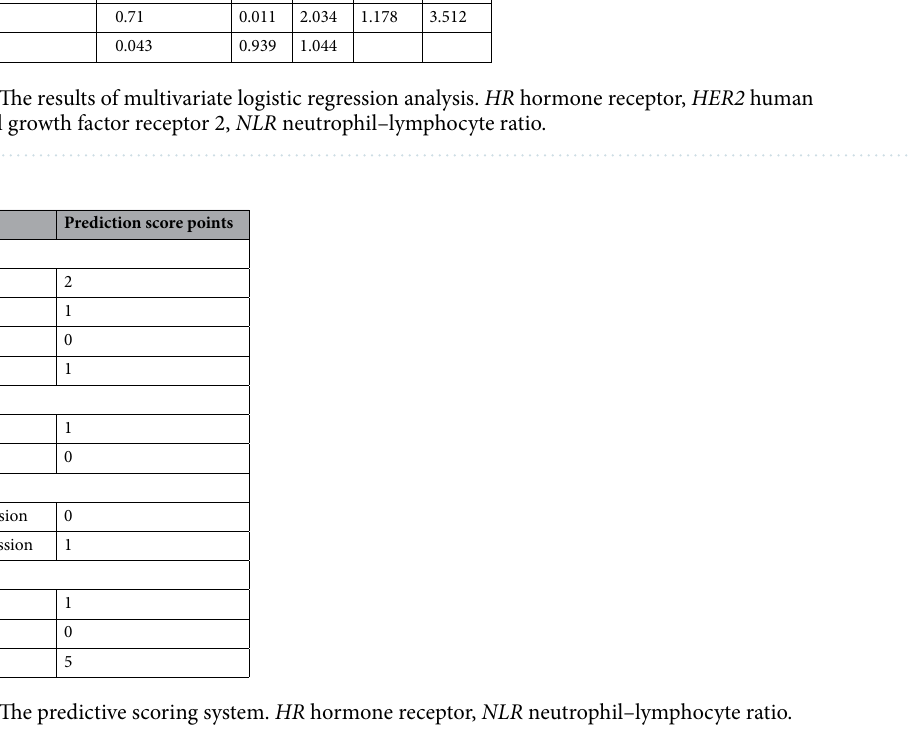
Table 4. The predictive scoring system. HR hormone receptor, NLR neutrophil–lymphocyte ratio.